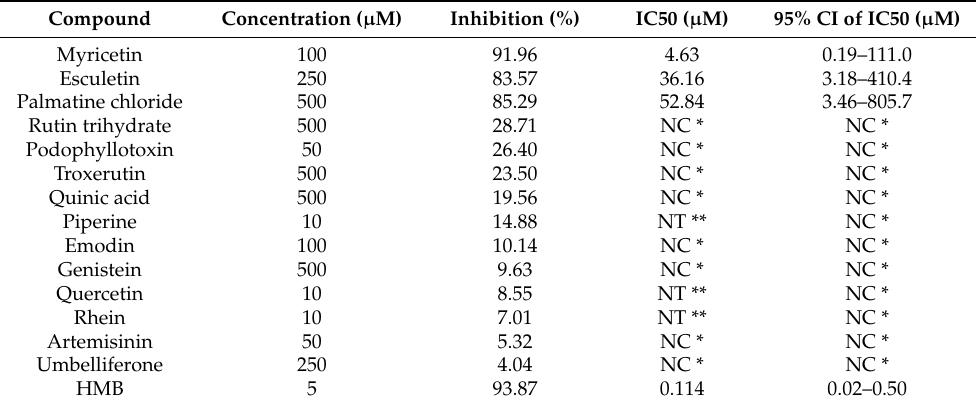
Table 1. The inhibitory effect on SrtA after 1 h of incubation.